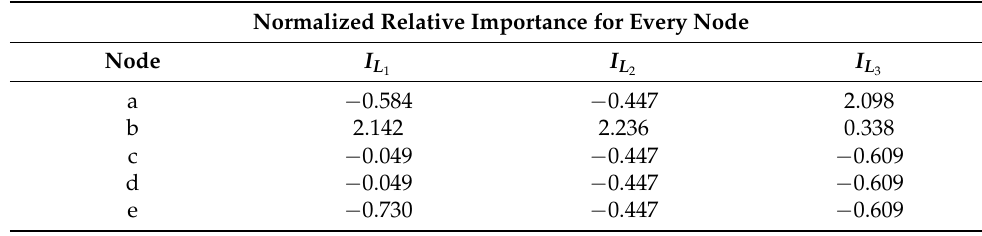
Table 2. Normalized relative importance of every node in layer L 1 from MLN4 in Figure 1. Normalized Relative Importance for Every